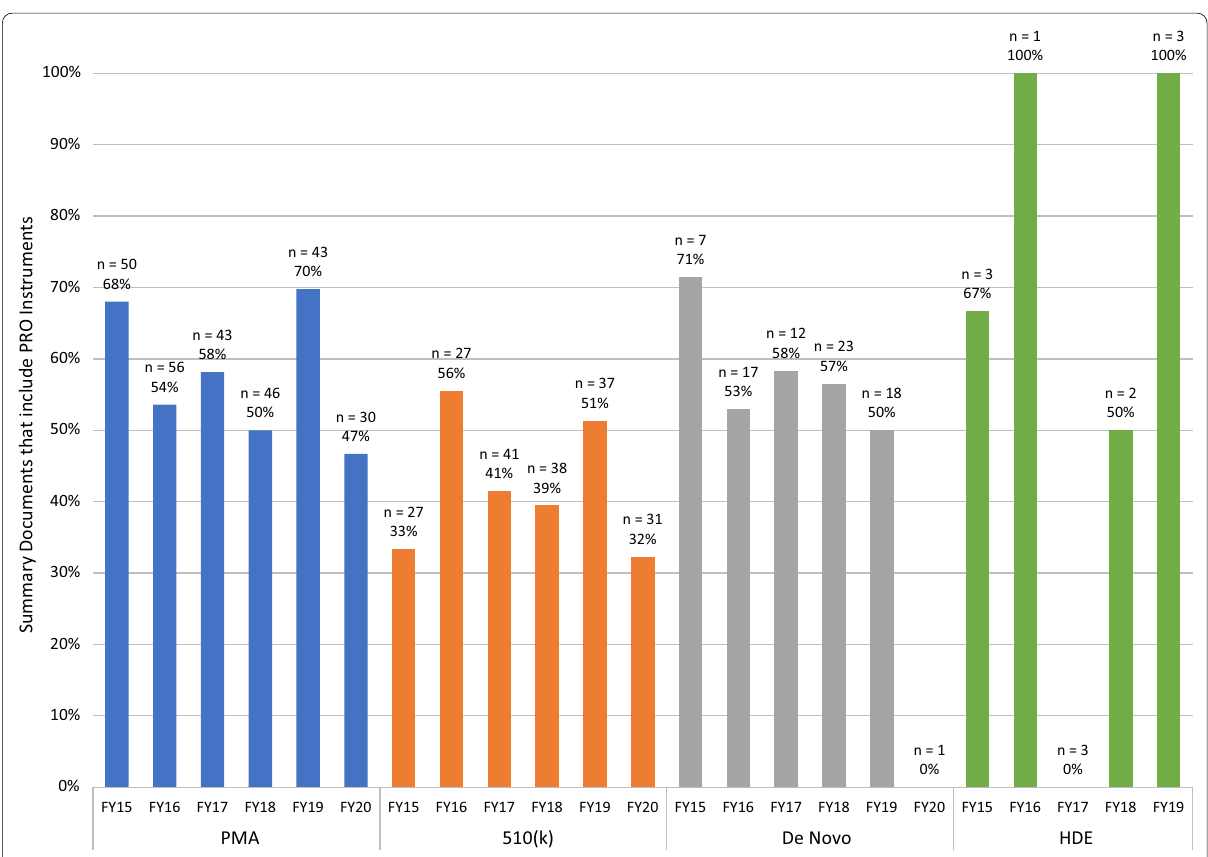
Fig. 1 PRO inclusion in summary documents fiscal year 2015- fiscal year 2020. The 510(k) cohort consisted of cleared 510(k)s that included clinical trial data. The majority of De Novos granted in fiscal year 2020 did not have summary documents posted within the study window leading to the